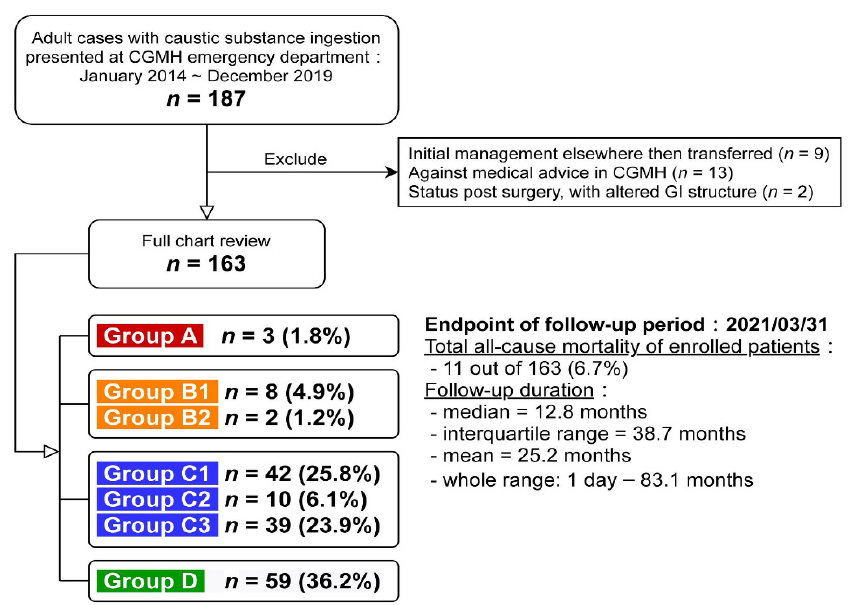
Figure 2. Enrollment diagram of the study population. Abbreviations: CGMH, Chang Gung Memo- rial Hospital; GI, gastrointestinal. rial Hospital; GI,